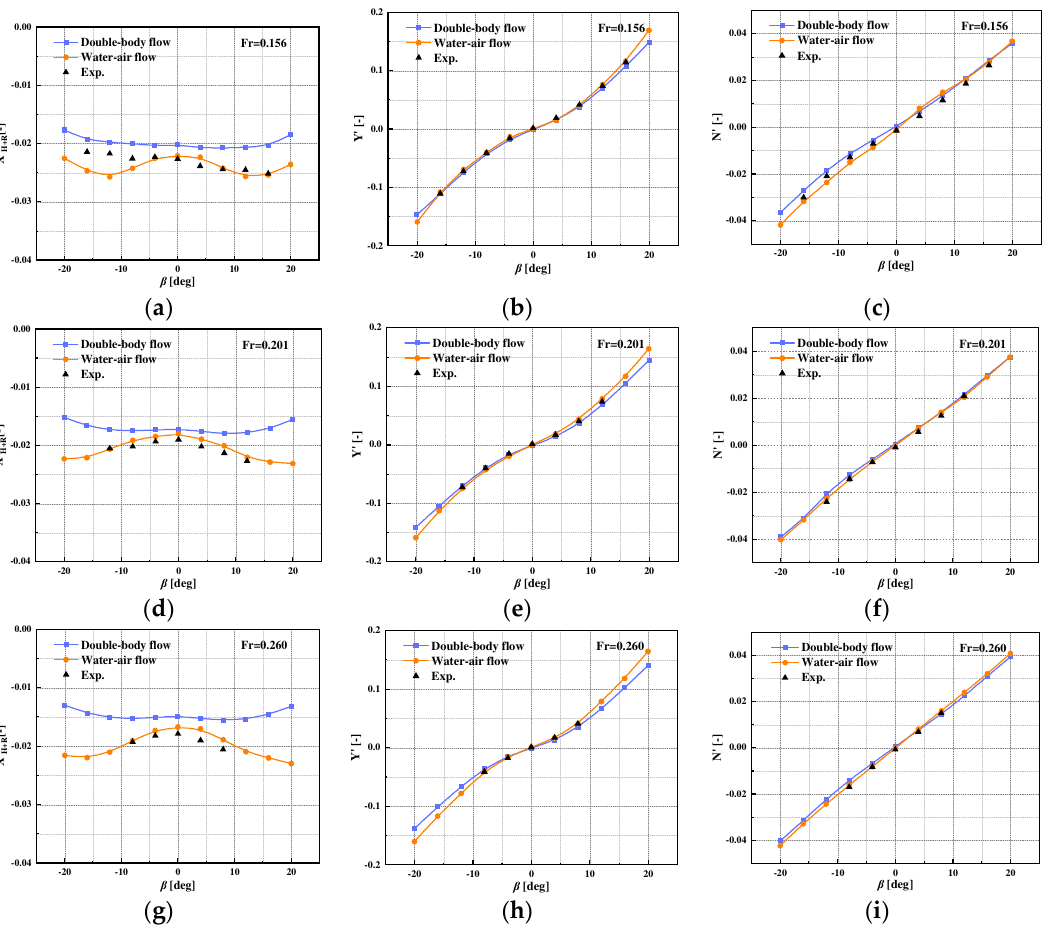
Figure 3. Comparison of CFD and EFD for static drift motion. ( a ): X (cid:48) H + R , Fr = 0.156. ( b ): Y (cid:48) , Fr = 0.156. ( c ): N (cid:48) , Fr = 0.156. ( d ): X (cid:48) , Fr = 0.201. ( e ): Y (cid:48) , Fr = 0.201. ( f ): N (cid:48) , Fr = 0.201. H + R ( g ): X (cid:48) , Fr = 0.26. ( h ): Y (cid:48) , Fr = 0.26. ( i ): N (cid:48) , Fr = 0.26. H + R Table 10. The error between the CFD computed results and EFD data for double-body flow simulation, Fr =